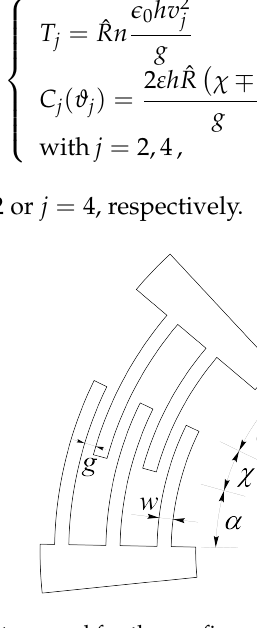
Figure 6. Parameters used for the configuration of the comb